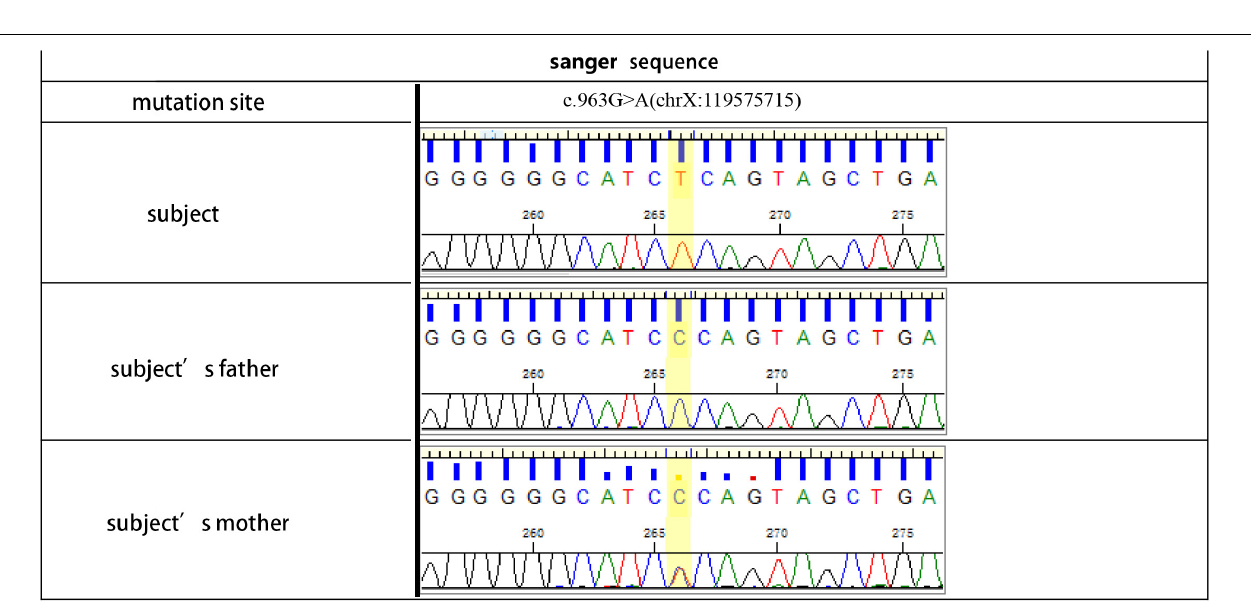
Frontiers in Cardiovascular Medicine |